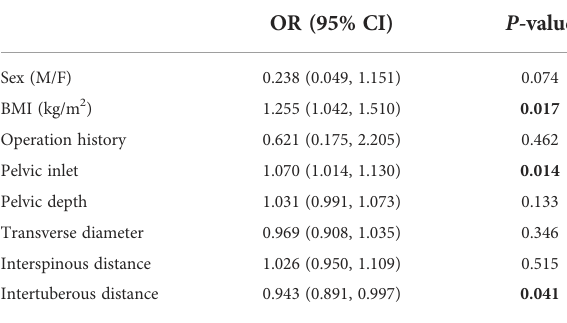
TABLE 5 Multivariable logistic regression analyses of associations between predictive factors and surgical dif fi culty level.